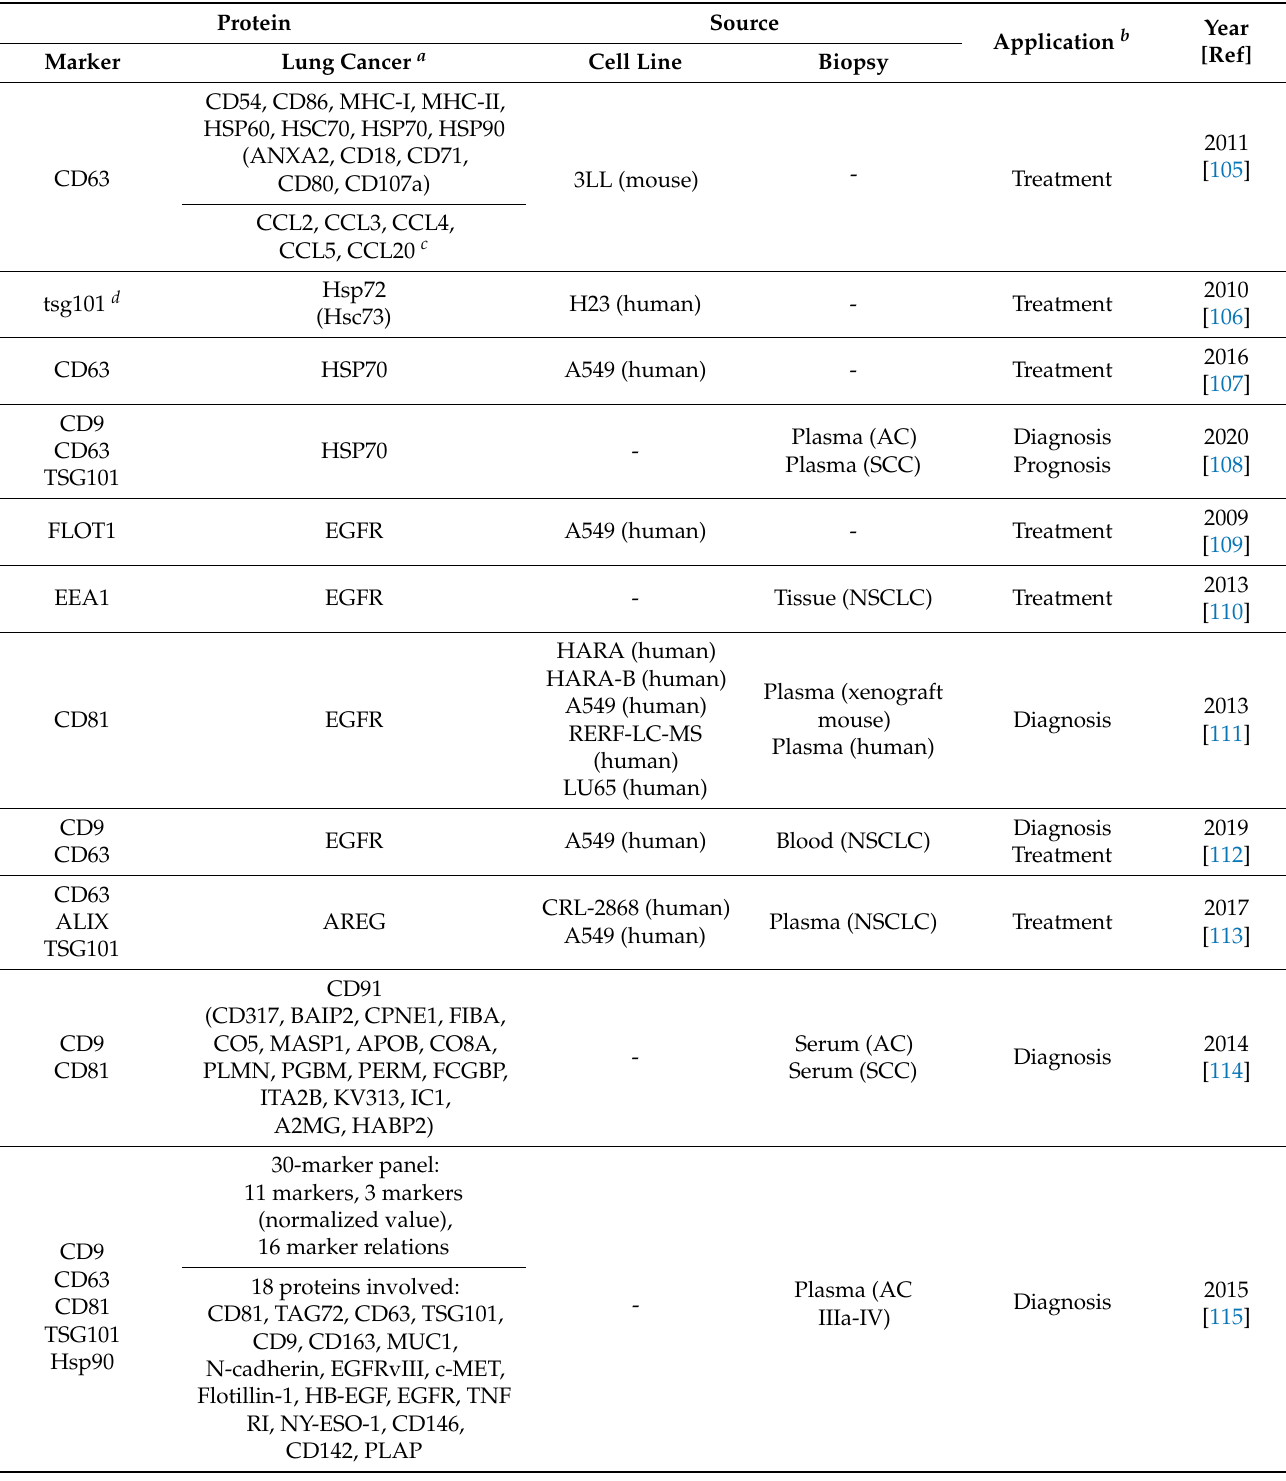
Table 1. Protein composition and application of lung cancer